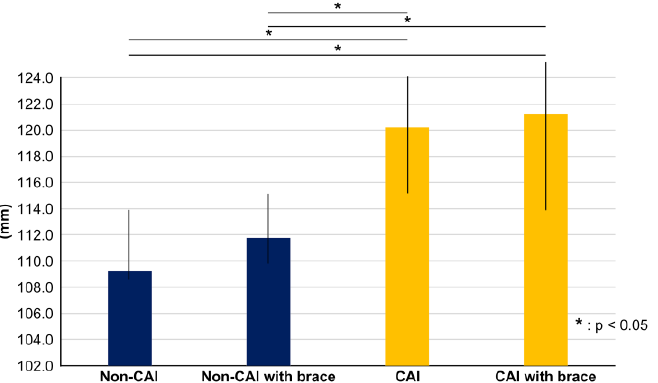
Figure 5. Graph showing the amount of change in transition distance of the center of pressure. There was a significant difference between the CAI and non-CAI sides, but there was no significant difference between with or without the brace.